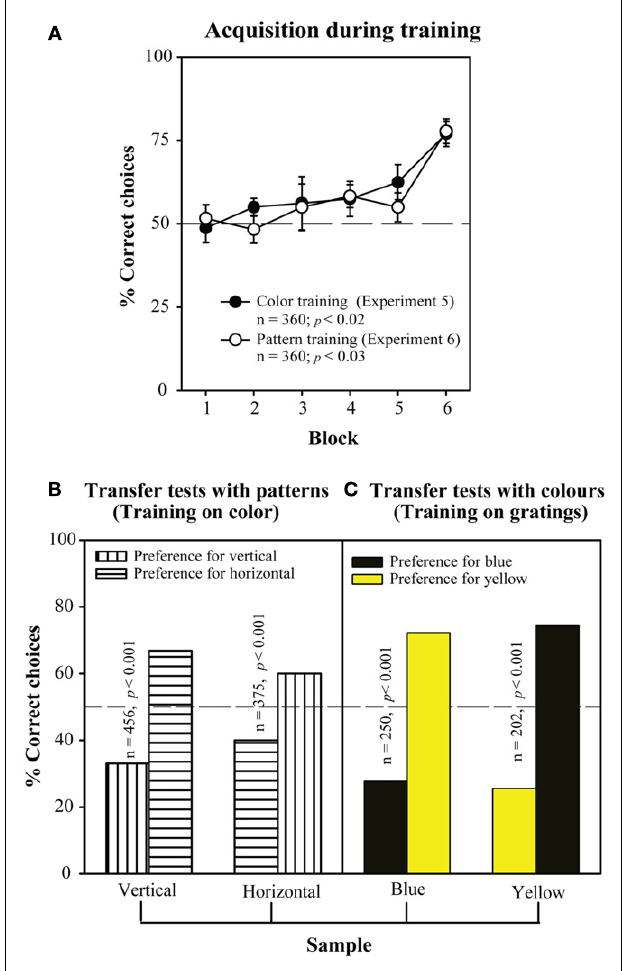
FIGURE 12 | Learning the concept of “difference”. Setup similar to Figure 11 , but the bees are rewarded for choosing the non-matching pattern. (A) Acquisition curve during the training phase. (B) Results of the transfer tests, after the bees were trained on color, and (C) after the bees were trained on patterns. Modified from Giurfa et al. (2001). Details in